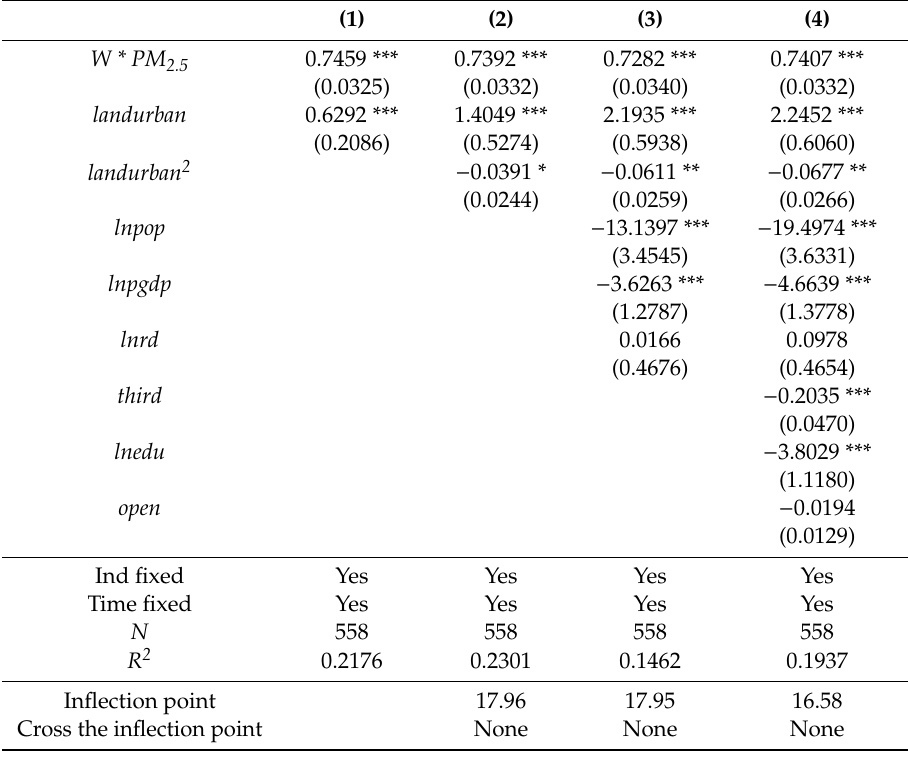
Table 4. Estimation results of the spatial autoregressive (SAR) panel data